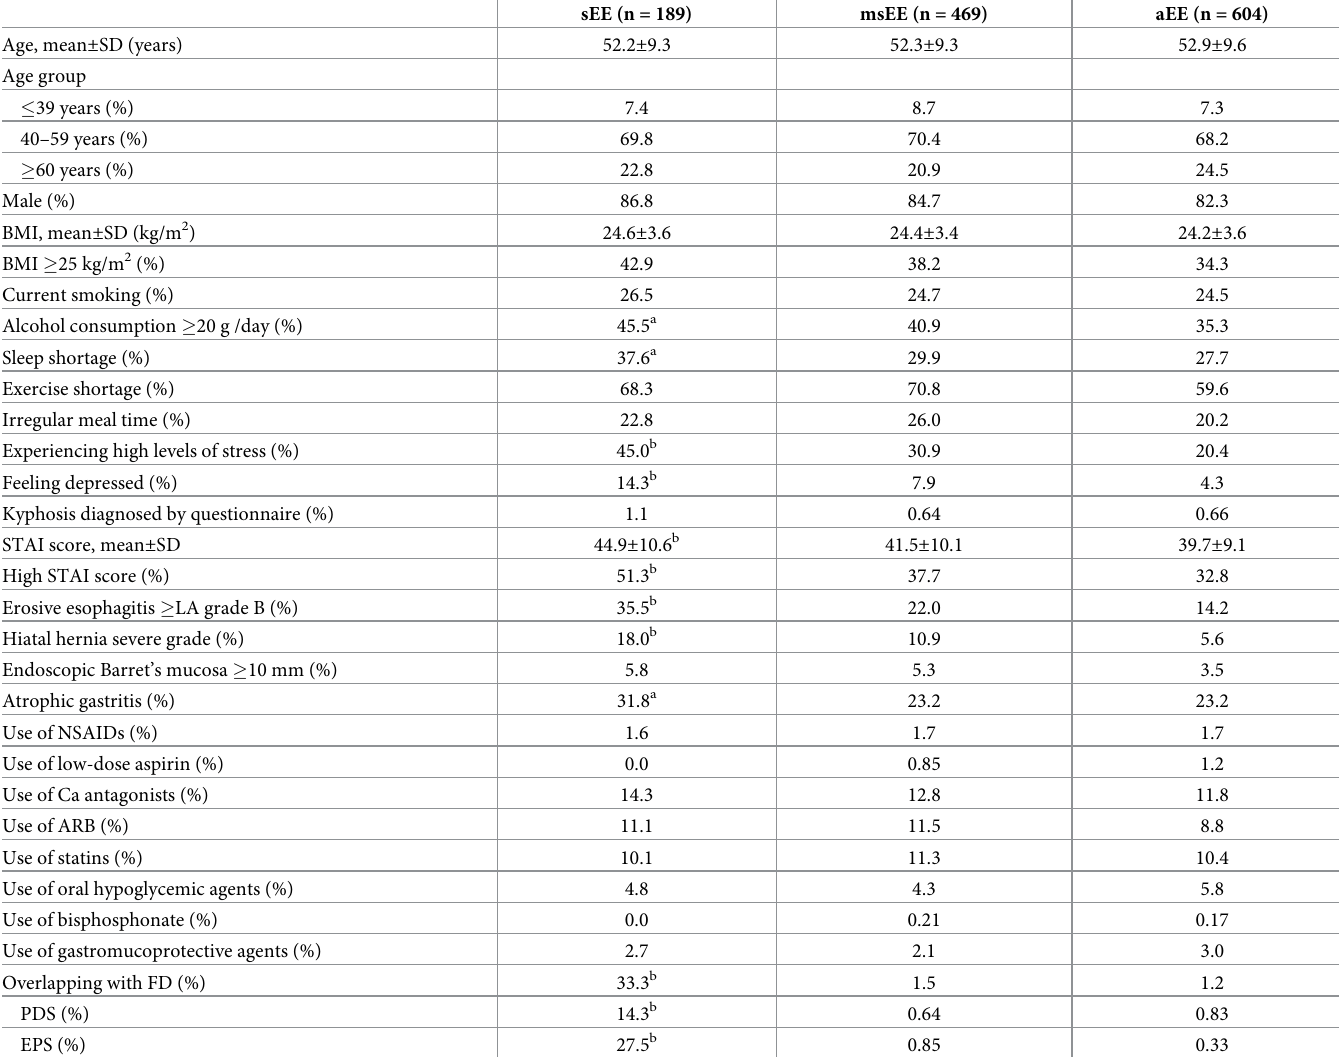
Table 4. Comparison of the clinical characteristics of the three erosive esophagitis groups according to the frequency of reflux symptoms. sEE (n = 189) msEE (n =